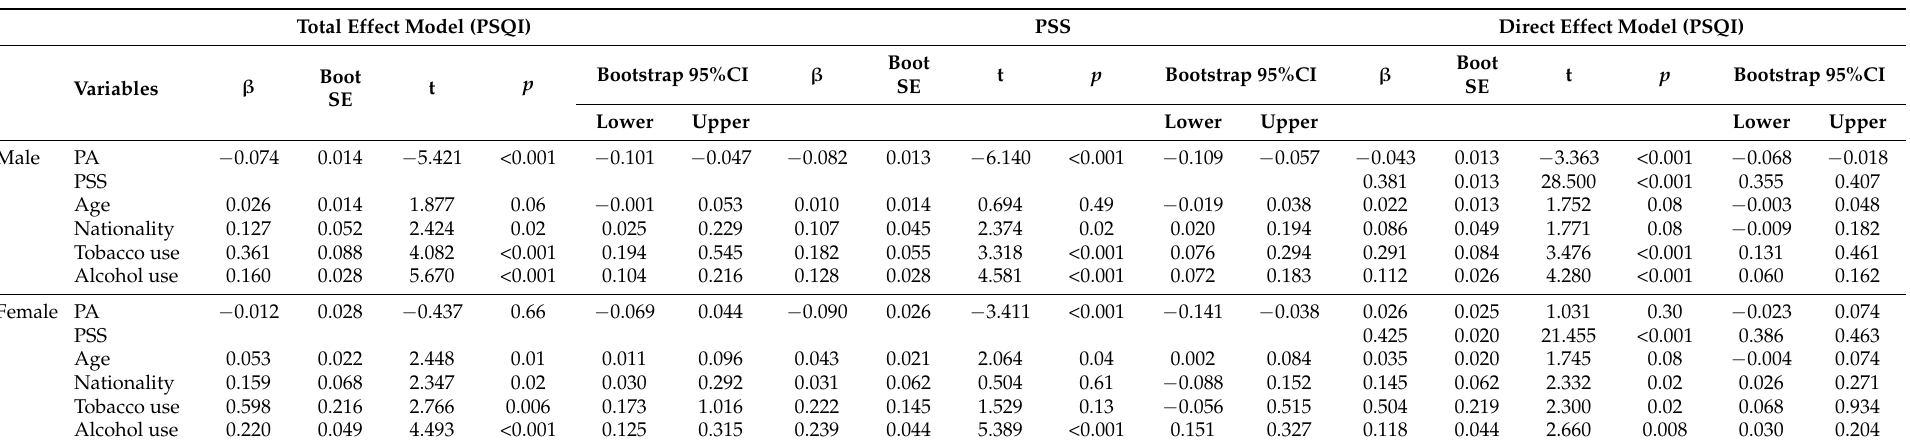
Table 2. Mediation analyses: association between physical activity and sleep quality via perceived